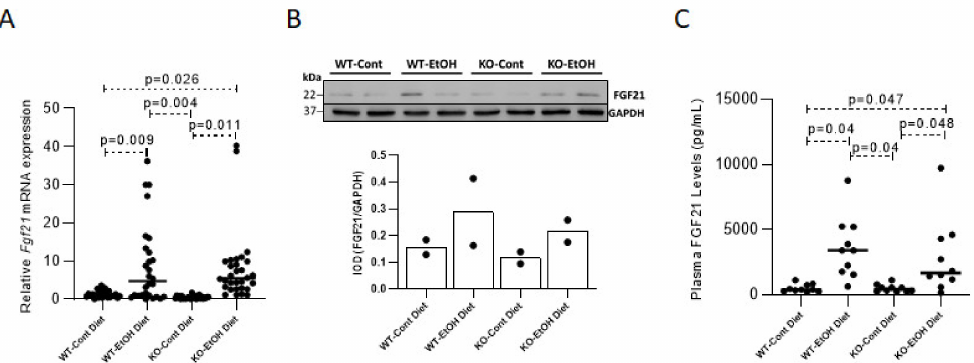
Figure 1. The effect of ethanol on FGF21 levels in liver and plasma. Relative quantification of Fgf21 mRNA levels in liver ( n = 28 per group) ( A ). Western blot quantification of FGF21 protein in mouse liver by integrated optical density (IOD) that was normalized to GAPDH as a control ( B ) ( n = 2 per group, each lane represents one mouse) and plasma FGF21 levels quantified by ELISA ( C ) ( n = 10 per group). p < 0.05 was considered significant. Cont, control diet; EtOH, ethanol diet; KO, Abcb4 knockout mice; WT, C57BL/6J wild-type mice.